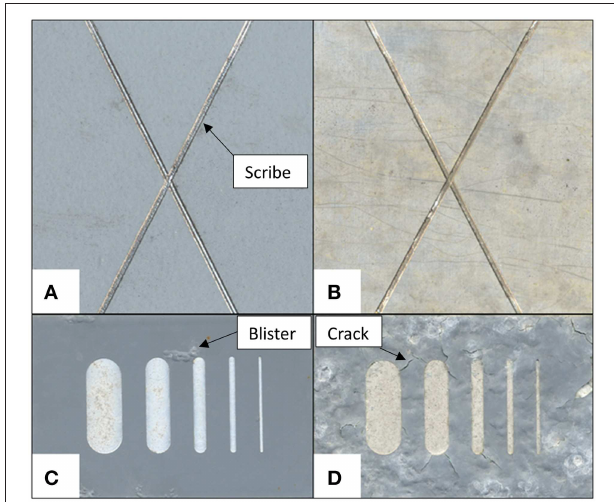
FIGURE 6 | Optical images exemplifying different types of coating defects, some of which are labeled. All coatings were deployed in field exposure testing with a machined scribe defect. In (A) a topcoated MgORP is shown after 2.5 years of exposure to Charlottesville, Va Birdwood golf course, and in (B) the same MgORP without a topcoat after being deployed in the same exposure conditions, resulting in the primer being completely degraded down to bare substrate. In (C) , one type of chromated primer is shown following exposure to Daytona, FL coastal marine environment for 3.2 years, exhibiting blistering in the coating, and in (D) a different chromate pigmented primer is shown following exposure to the same coastal environment, in which the coating exhibited severe